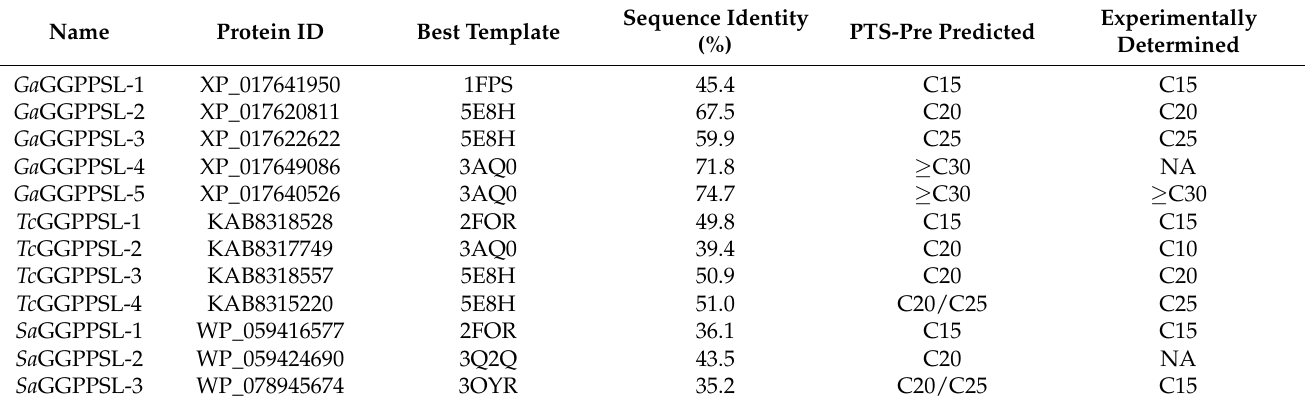
Table 1. The predicted and experimentally verified trans -PTs from three randomly selected